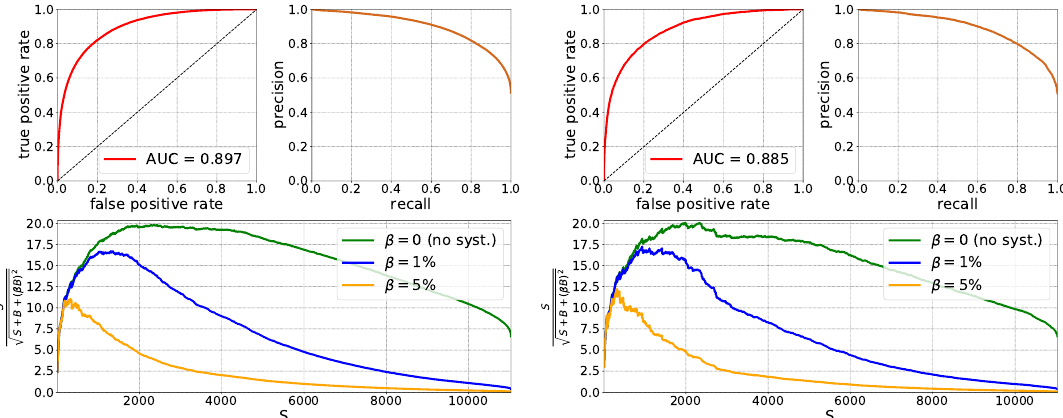
Figure 7 . Training (left) and evaluation (right) results of the BDT analysis for the symmetric benchmark S 750 350 25, using a fat-jet radius of R = 1 : 2. The lower panels show the signi(cid:12)cance p (cid:6) as a function of the expected signal events S for s = 14 TeV and L = 3 ab (cid:0) 1 . the outcome of the evaluation. In the upper left plot of each panel, we present the